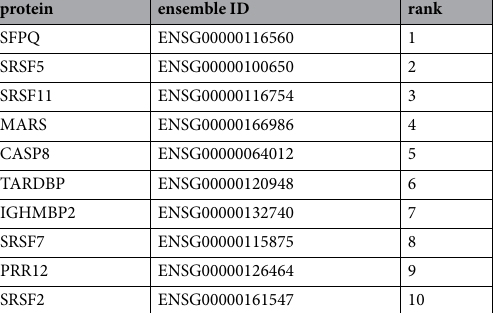
Table 3. The top 10 ranked proteins for lncRNA MALAT1(ensemble ID: